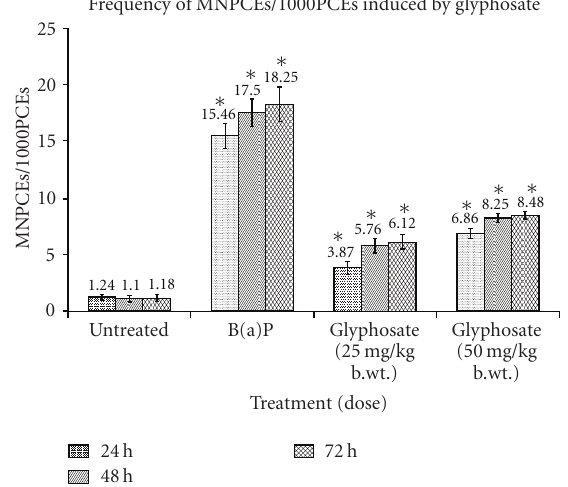
Figure 4: Mutagenic activity of glyphosate in Swiss albino mice showing increased micronuclei (MN) induction at sampling time of 24, 48, and 72 hours. Values are expressed as mean ± SE of five animals. ∗ Represent significant increase over untreated control group at their respective sampling time. Data were significant as P < .05. MNPCEs: Micronucleated polychromatic erythrocytes and PCEs: polychromatic